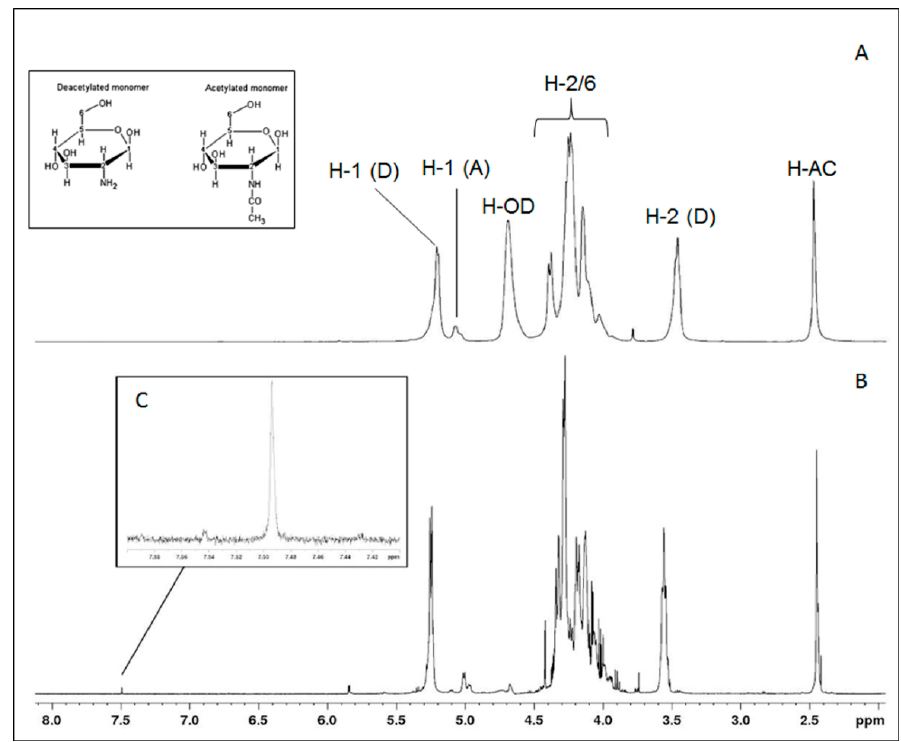
Figure 2. NMR spectra for Chit ( A ) and Chit-Gal ( B ). The identified signals correspond to the typical signs of Chit, present in both samples. H-AC corresponds to the hydrogens of the methyl group of N-acetylglucosamine; D and A correspond to deacetylated and acetylated unities, respectively. H-OD indicates hydrogens of deuterium oxide. Highlighted is the signal at 7.49 ppm ( C ), present only in the Chit-Gal spectrum and corresponds to the hydrogen from the aromatic